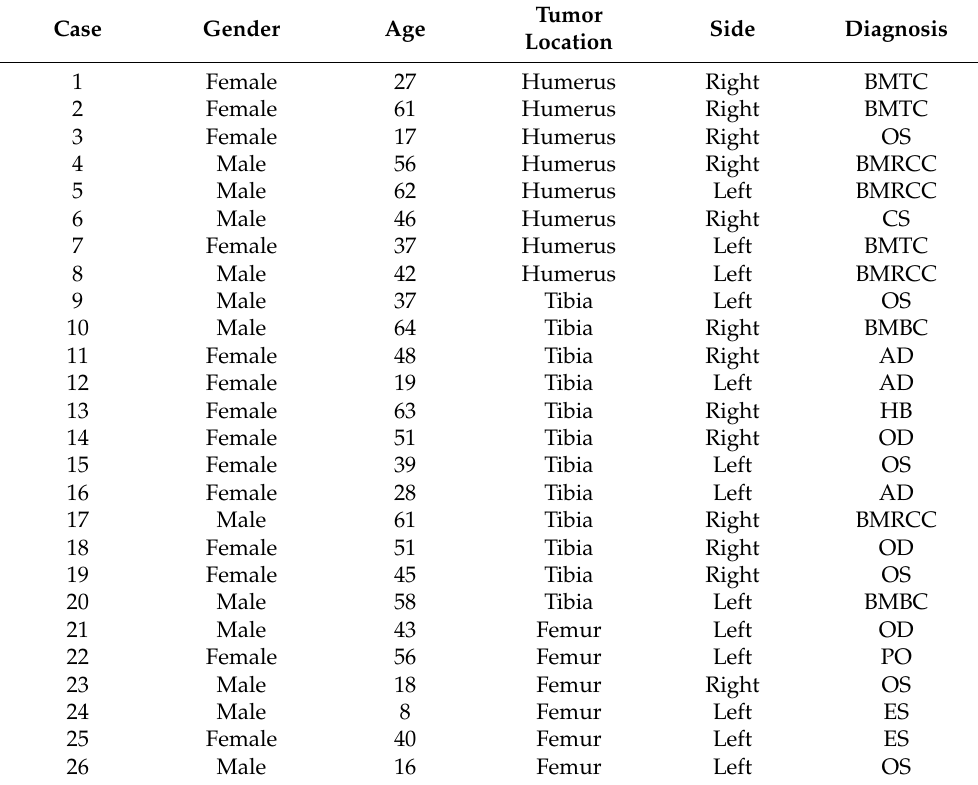
Table 1. Demographic Data of the 26